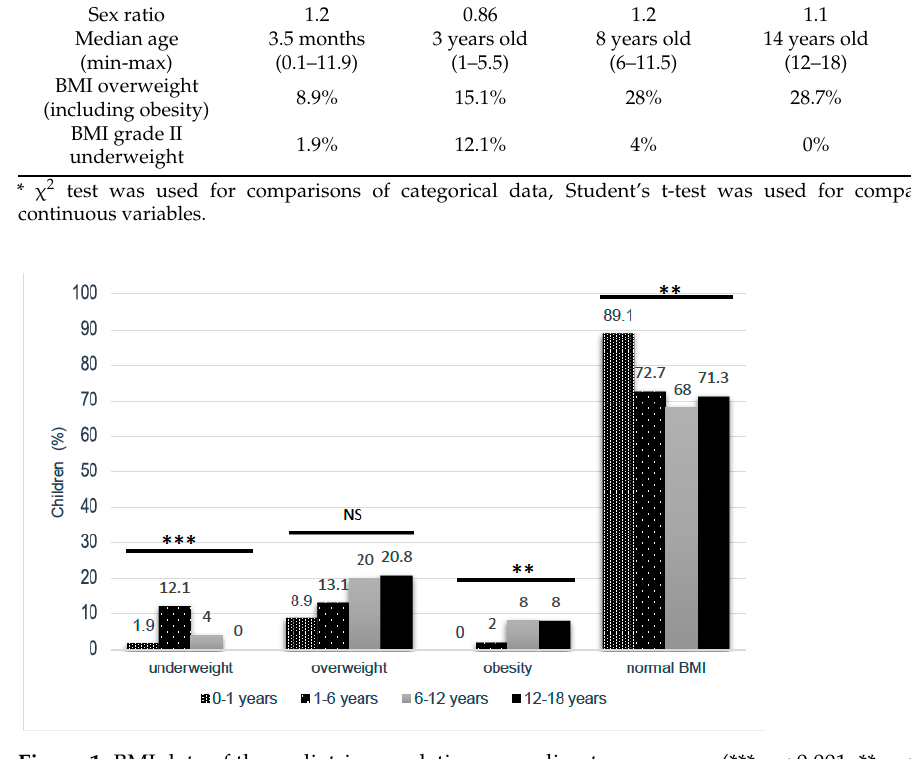
Table 1. Demographic data and BMI data of the pediatric population, by age group.